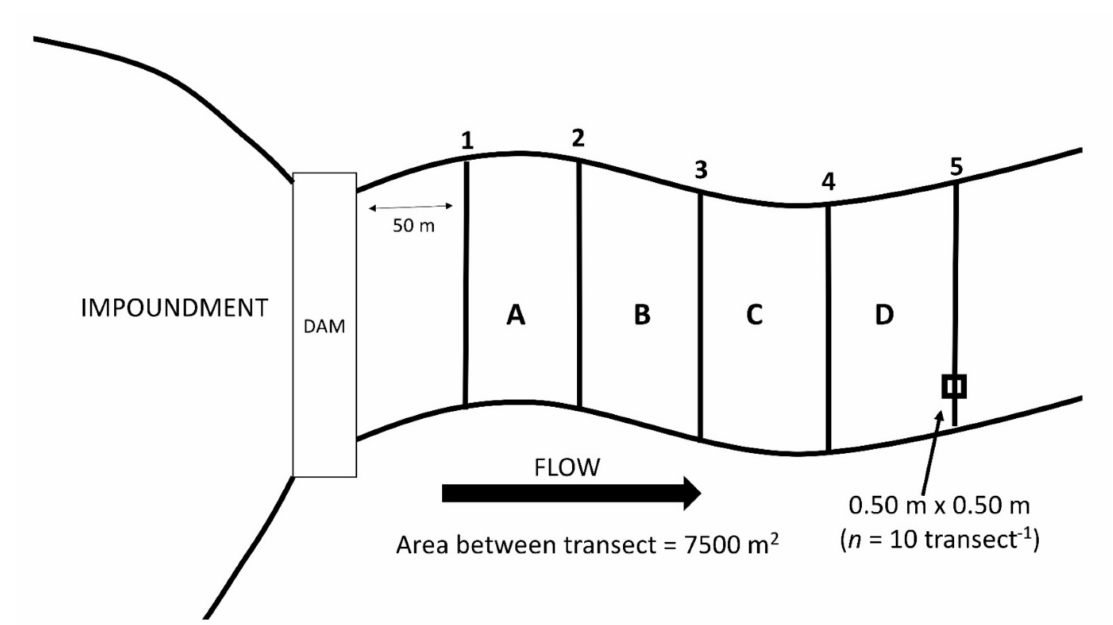
Figure 2. Standardized sampling design downstream of anthropogenic barriers. Semi-quantitative timed-searches were performed between transects ( n = 4 per site; A–D; 1-person hour for every 2500 m 2 ). Quantitative sampling consisted of quadrats ( n = 10; 0.50 m × 0.50 m) randomly distributed along each transect ( n = 5 per site;